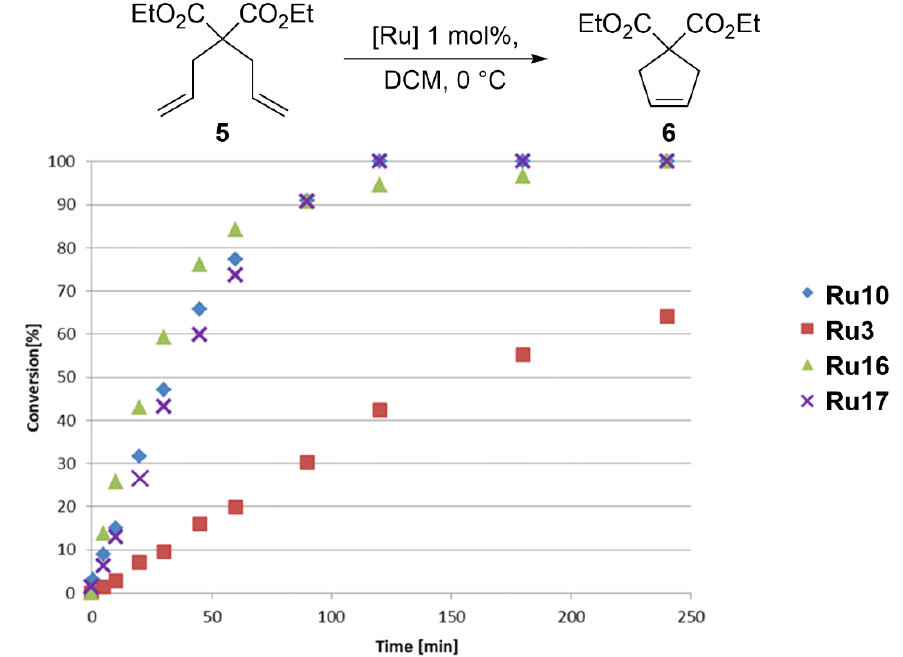
Figure 5. Relative conversion rates for a model RCM reaction of 5 using 1 mol% of the catalyst.